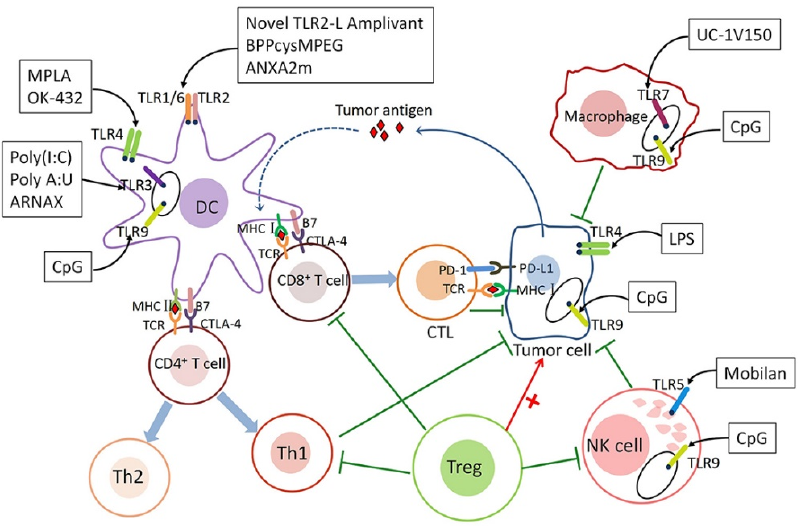
Figure 1. The mechanism underlying the role of TLRs in tumor immunity. Reprinted with permission from Ref. [21] . Copyright 2020, copyright Frontiers.